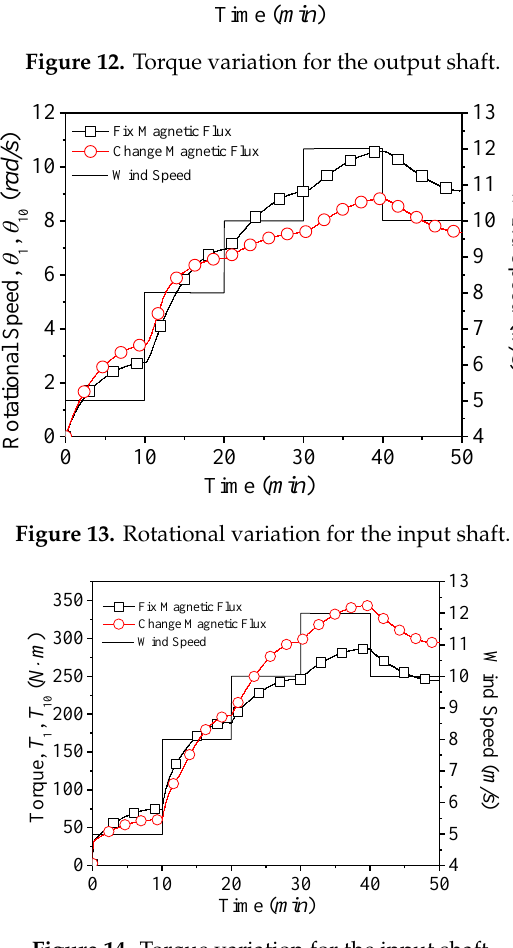
Figure 12. Torque variation for the output shaft.